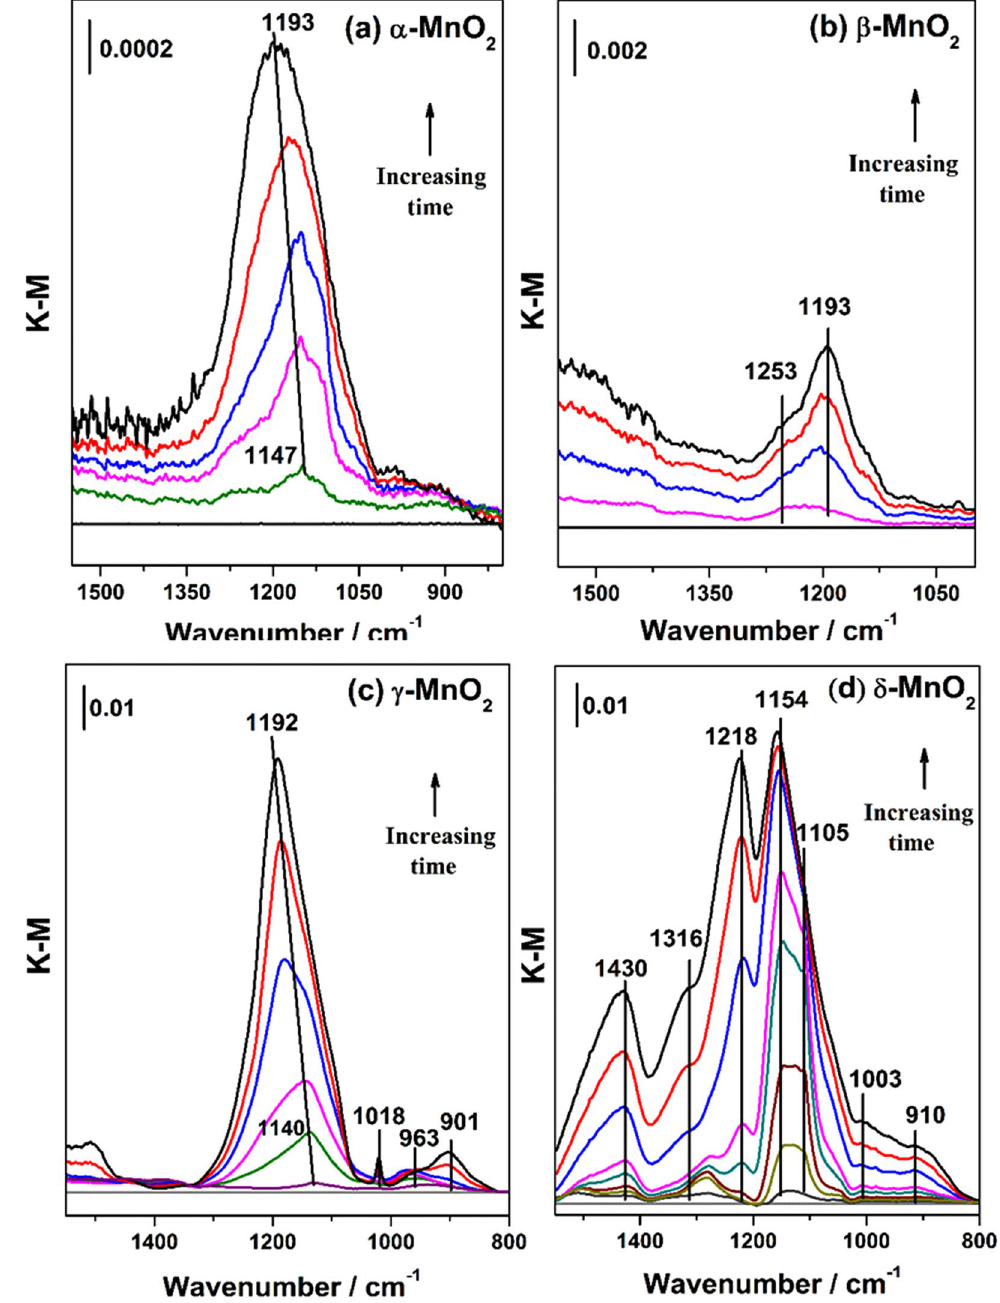
Figure 8. DRIFTS spectra recorded on manganese oxides exposed to 40 ppmv SO 2 as a function of time under 40% RH. The total flow was 100 mL/min and reaction time was 60